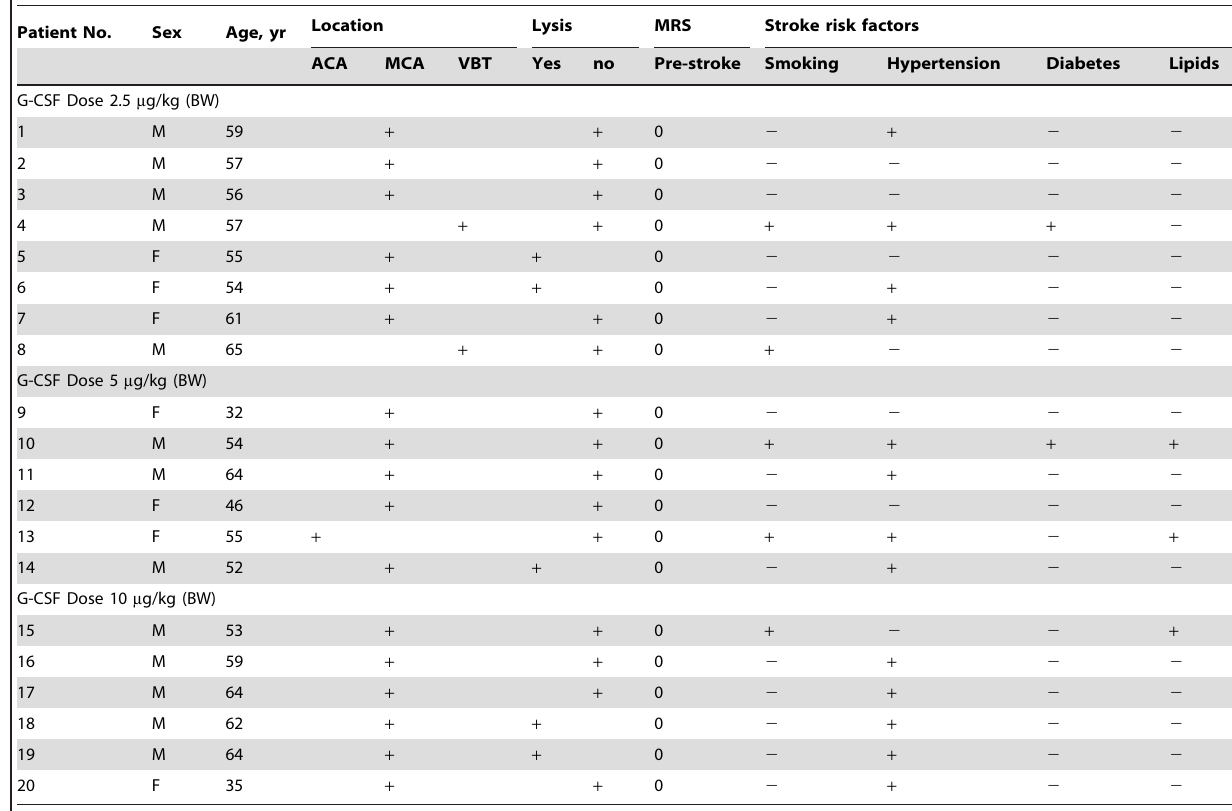
Table 2. Baseline characteristics of intention-to-treat population.